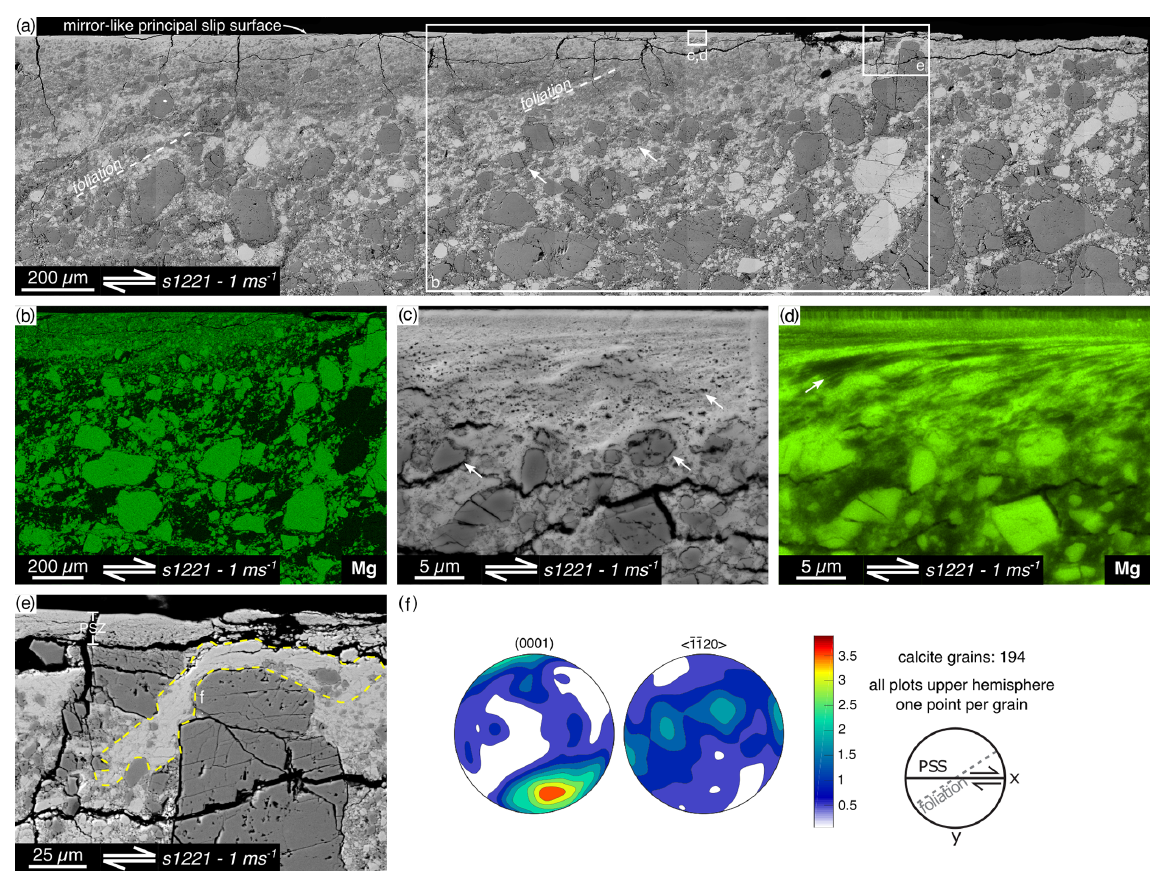
Figure 9. Microstructures of experiments in room-humidity conditions and V = 1ms − 1 . (a) Development of a foliation consisting of al- ternation of calcite- and dolomite-rich domains that are antithetically inclined ca. 40 ◦ from the principal slip surface (PSS) and become sub-parallel to the gouge boundaries when approaching the PSS. Larger dolomite (and when present calcite) clasts have tails of fine-grained material, resembling mantled porphyroclasts. (b) Mg element map highlighting foliation development in the bulk gouge. (c) Dolomite clasts adjacent to the principal slip zone are characterised by internal holes and vesicular rims interpreted being as due to degassing during dolomite decarbonation reaction. Banding of low and higher porosity in the principal slip zone is an indicator for dolomite content. (d) Mg element map of (c) , showing dolomite and calcite banding in the principal slip zone. (e) Transition from the principal slip zone to the underlying frac- tured and foliated gouge, with calcite showing evidence of dynamic recrystallisation. (f) Orientation data for calcite in the area highlighted in (e) showing the development of a clear CPO along the c